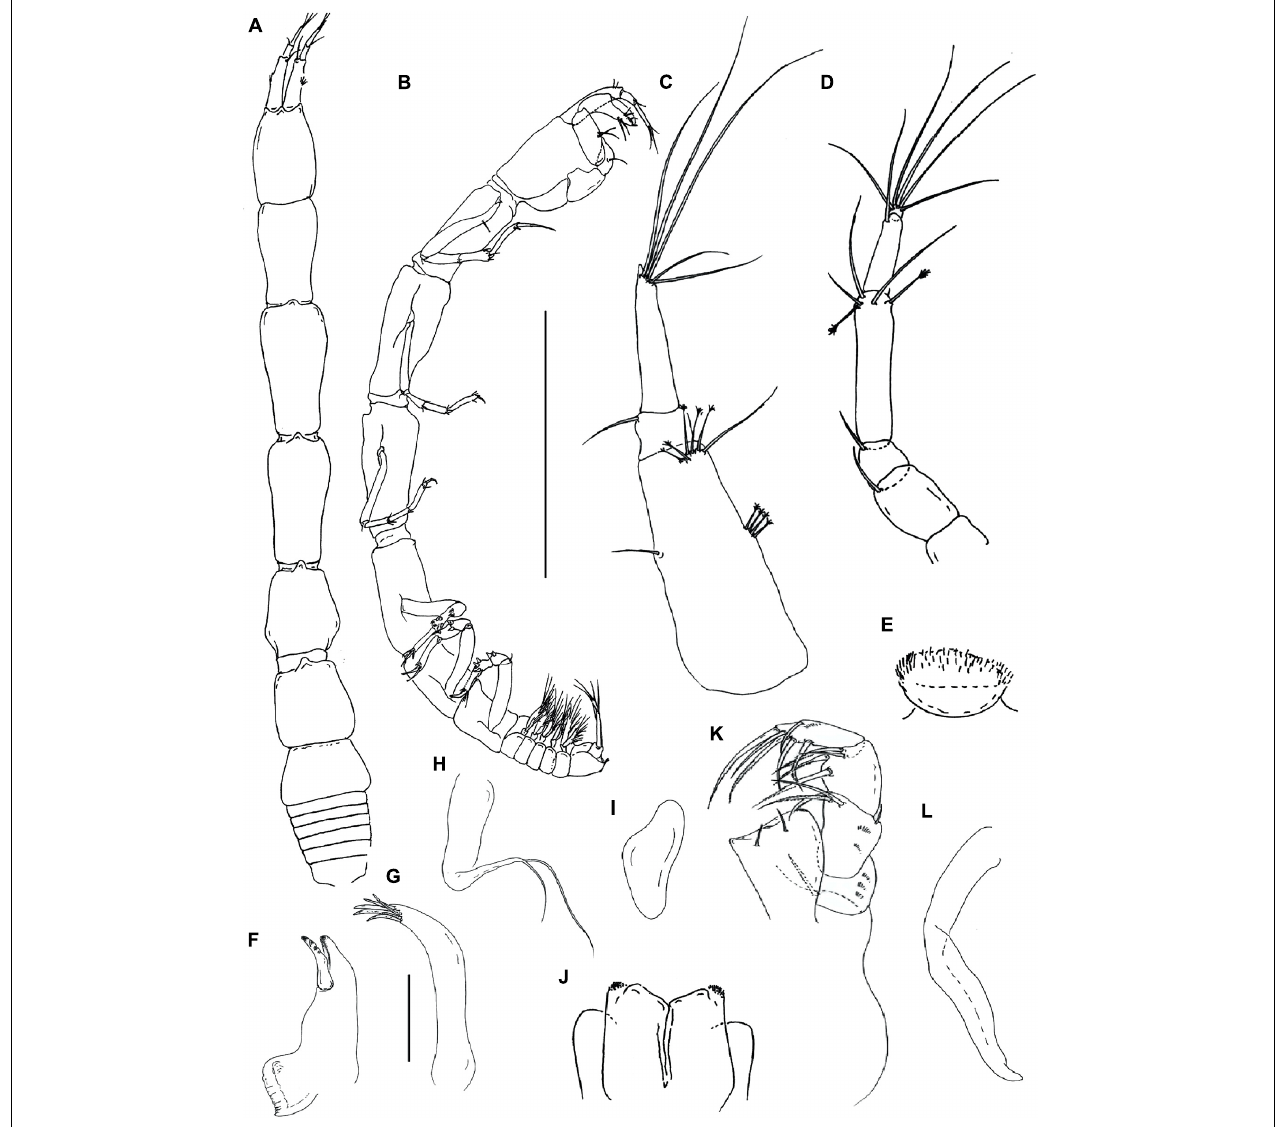
FIGURE 9 | Hamatipeda lelibi n. sp. (J57937) (A,B) neuter; (C) antennule; (D) antenna; (E) labrum; (F) mandible left; (G,H) maxilla endite and palp; (I) maxilla; (J) labium; (K) maxilliped; (L) epignath. Scale: panels (A,B) = 1 mm, panels (C–L) = 0.1